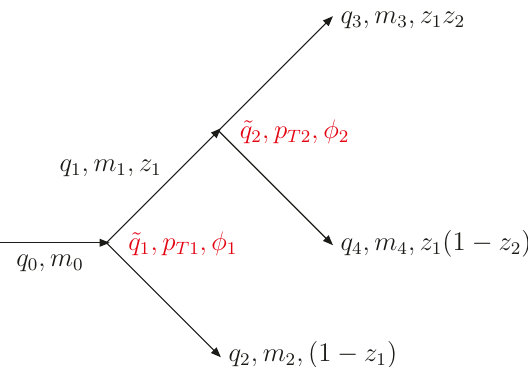
Figure 1 . The kinematics of two branchings in the angular-ordered parton shower. The o(cid:11)-shell momenta ( q i ), on-shell masses ( m i ) and light-cone momentum fractions of the partons are shown together with the evolution variable (~ q i ), transverse momentum ( p Ti ) and azimuthal angle ( (cid:30) i ) of each